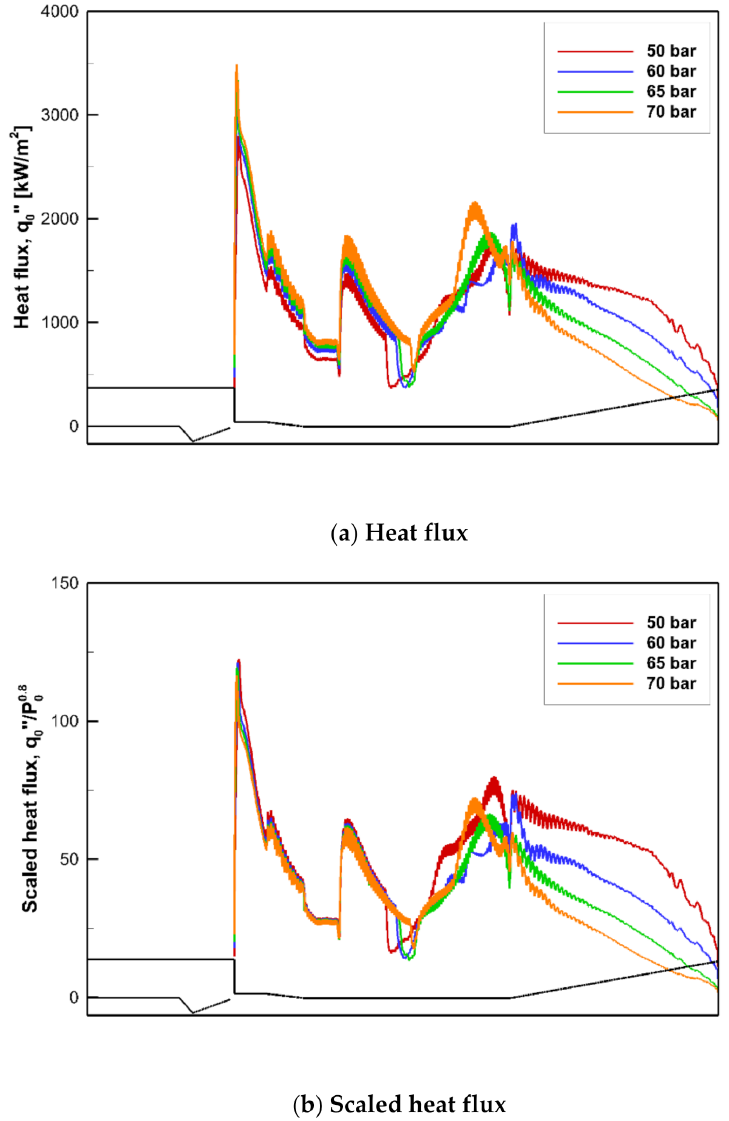
Figure 16. Heat flux characteristics of the baseline diffuser for various P 0 at the hot gas-side